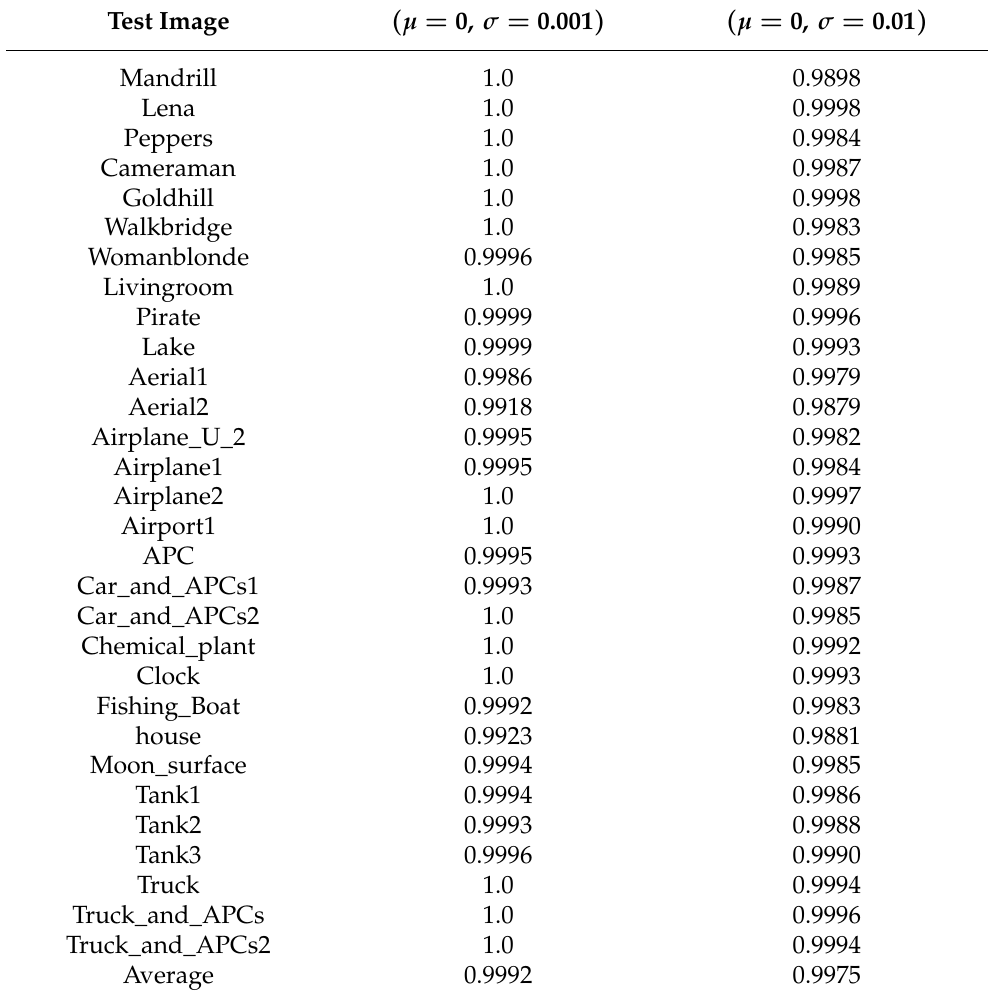
Table 3. Watermark robustness measured in terms of NC against salt and pepper noise for several test